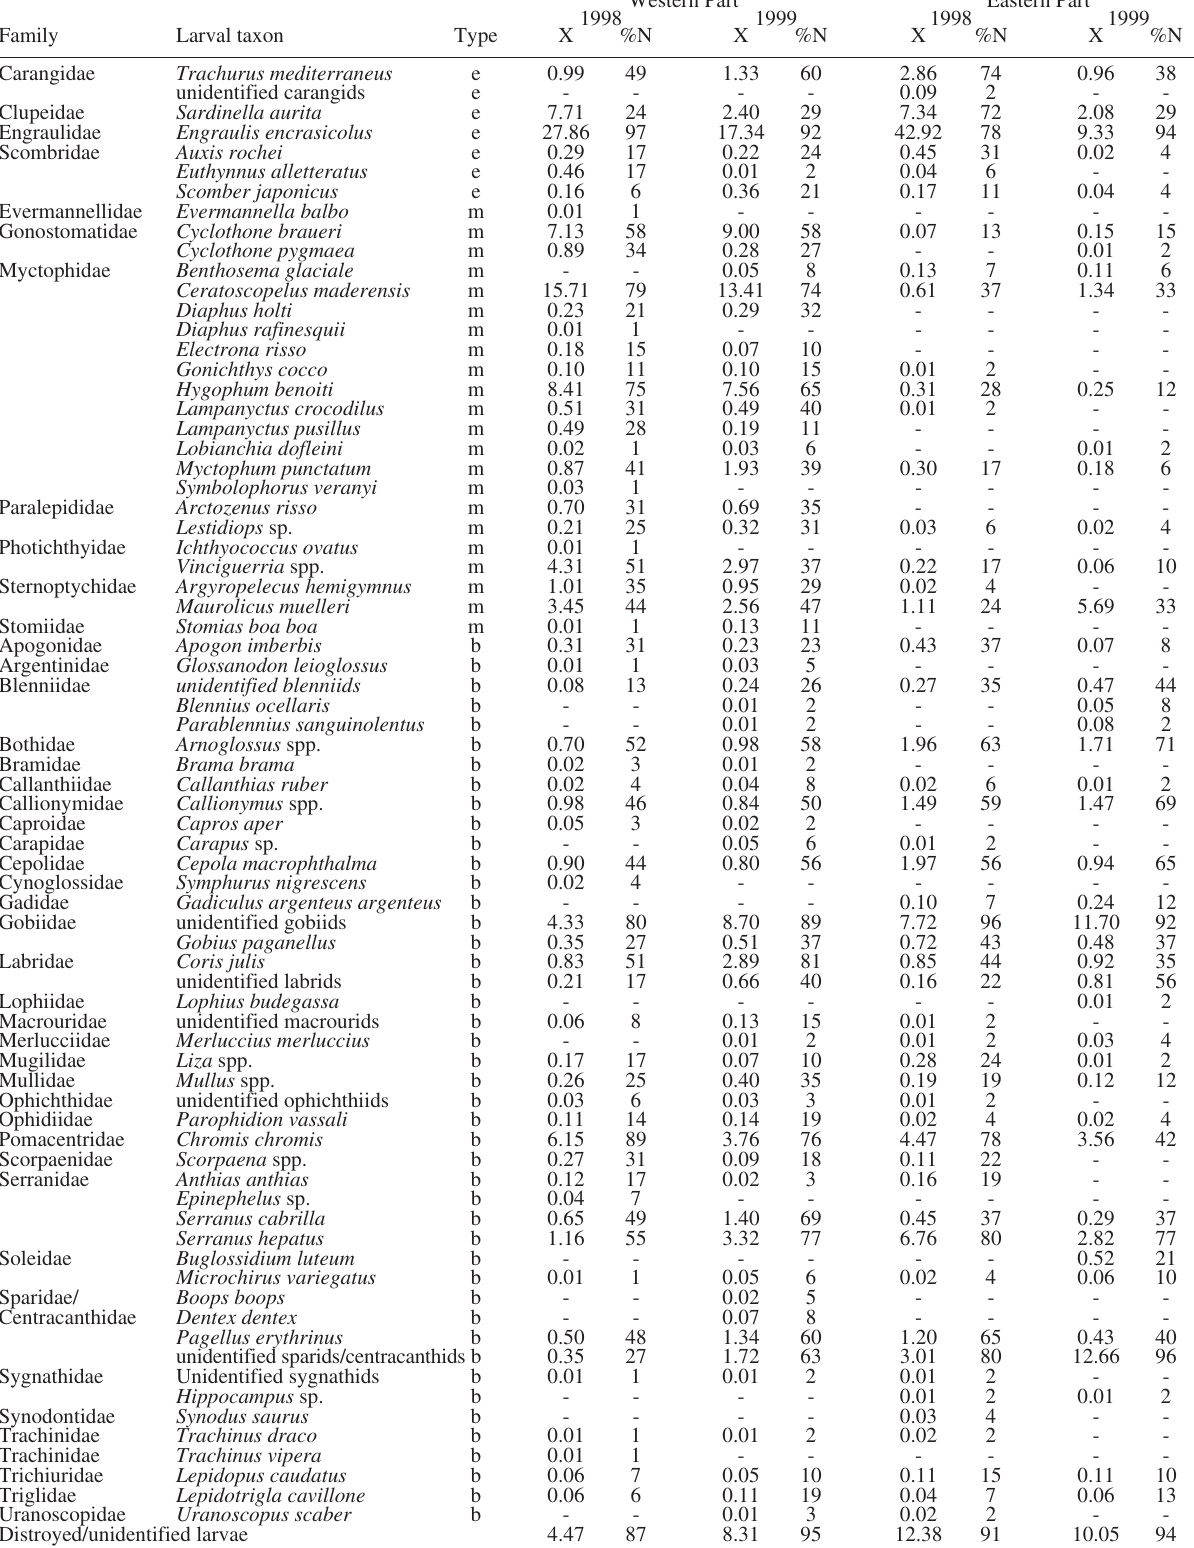
Table 1. – Larval fish taxa identified from the surveys of July 1998 and June 1999. X, mean abundance (larvae m -2 ); %N, percent of positive stations (frequency of occurrence). Taxa are sorted by type (e, epipelagic; m, mesopelagic; b, benthopelagic). Families in each type are sorted alphabetically. Western Part Eastern Part